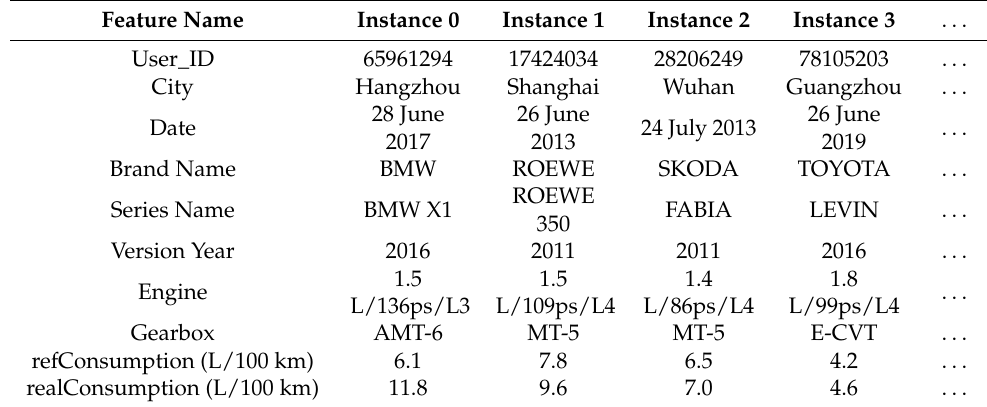
Table 1. Raw data example of real-world fuel consumption rate information from BearOil